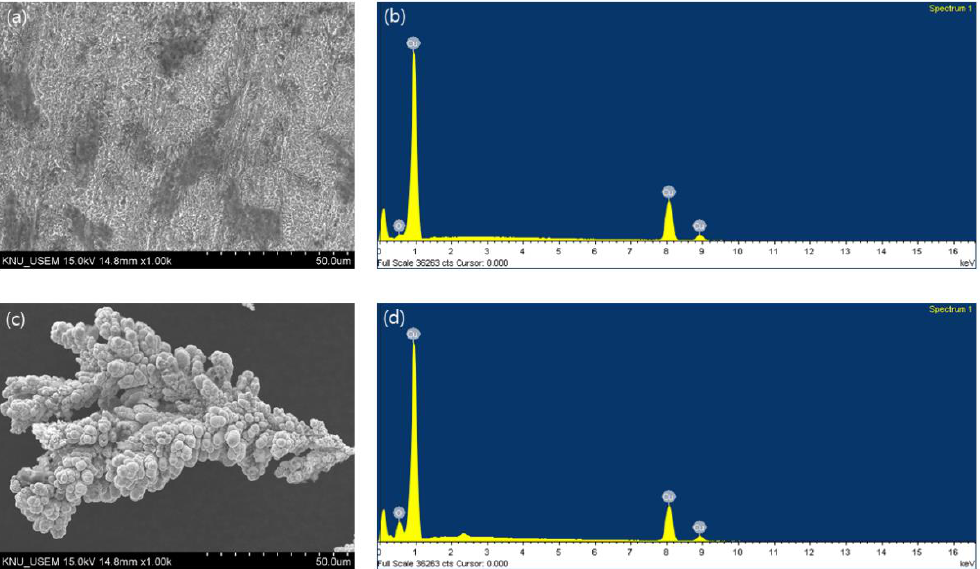
Figure 5. SEM-EDS images of deposited Cu at the current density ( a , b ) 10 mA/cm 2 ; ( c , d ) 30 mA/cm 2 . Electrodeposition conditions: H 2 SO 4 100 g/L, 4 h, 25 °C.